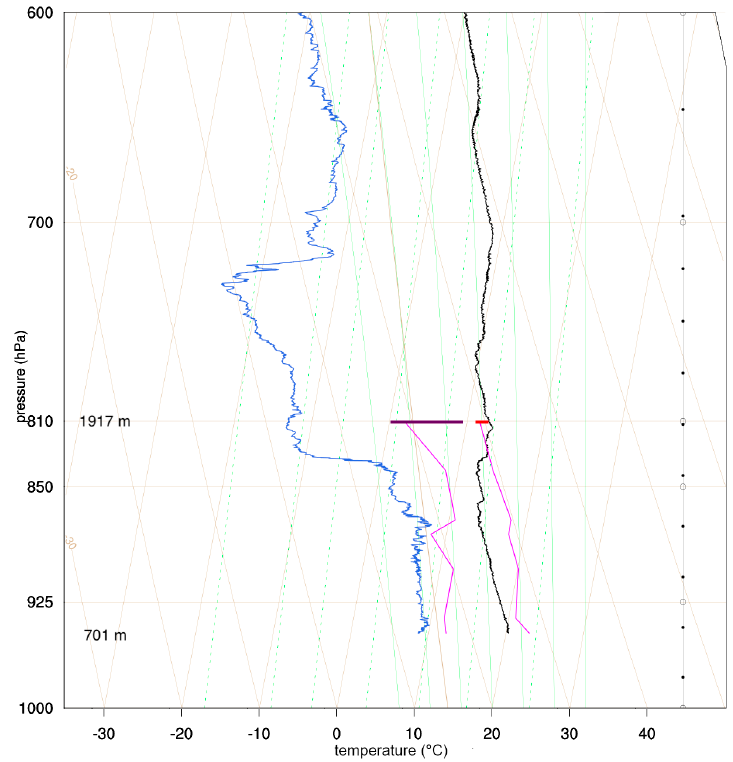
Figure 3. Skew-T diagram of the 1126 EST 19 August 2016 radiosonde profiles of temperature (black line) and dewpoint (blue line). Summit and Auto Road weather station temperature and dewpoint (magenta lines) are shown for comparison. The horizontal red and purples lines indicate the 1126–1136 EST range of summit temperature and dewpoint, respectively. The 810 hPa isobar indicates the summit station pressure on this day.